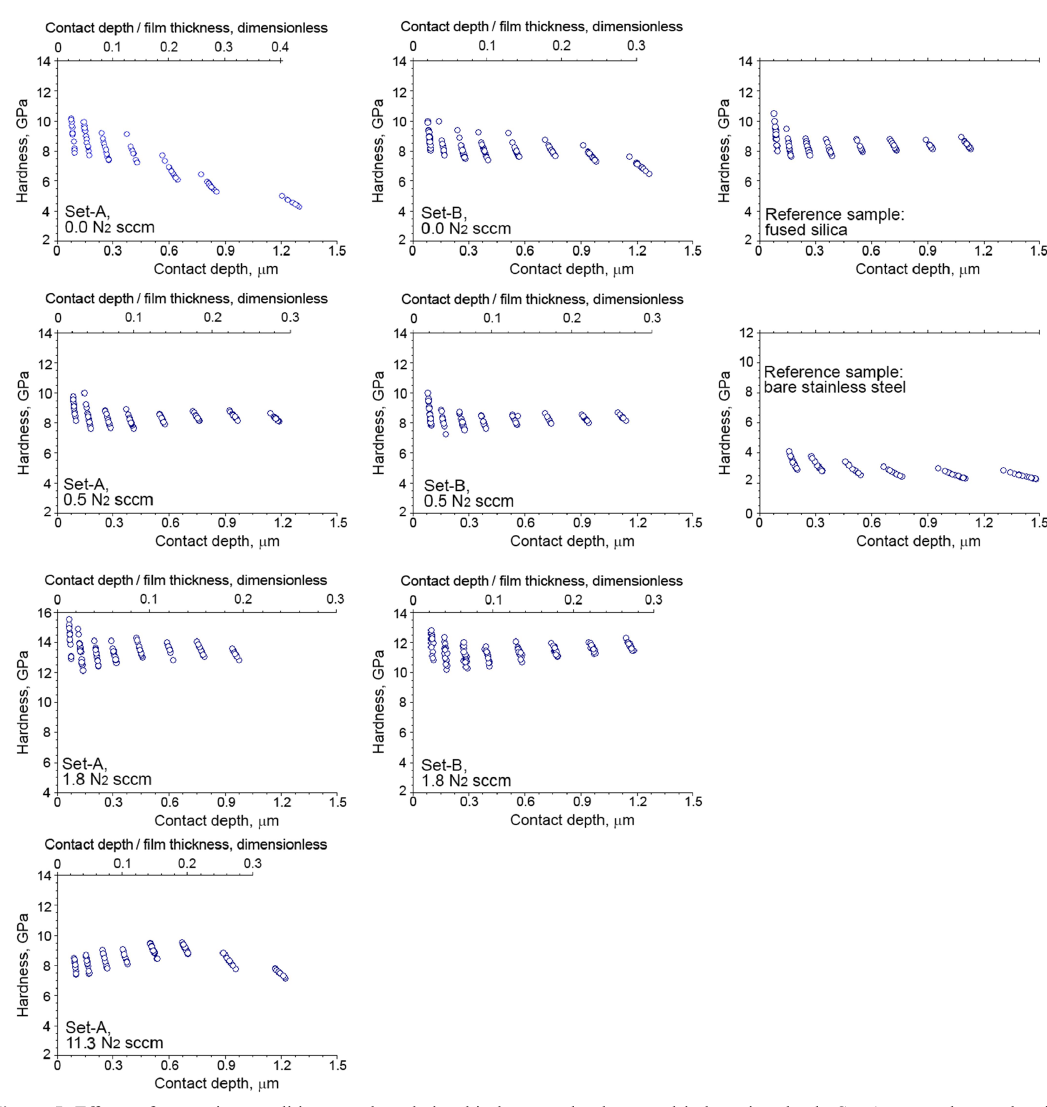
Figure 5. Effects of sputtering conditions on the relationship between hardness and indentation depth. Set-A: non-substrate heating, non-bias, 7 Wcm -2 ; Set-B: 573 K substrate heating, -250 V bias, 10.3 Wcm -2 . Results from on-top depth-sensing hardness with cyclical indentations at progressive maximum loads are reported. Maximum load varied from 5 to 245 mN. Berkovich